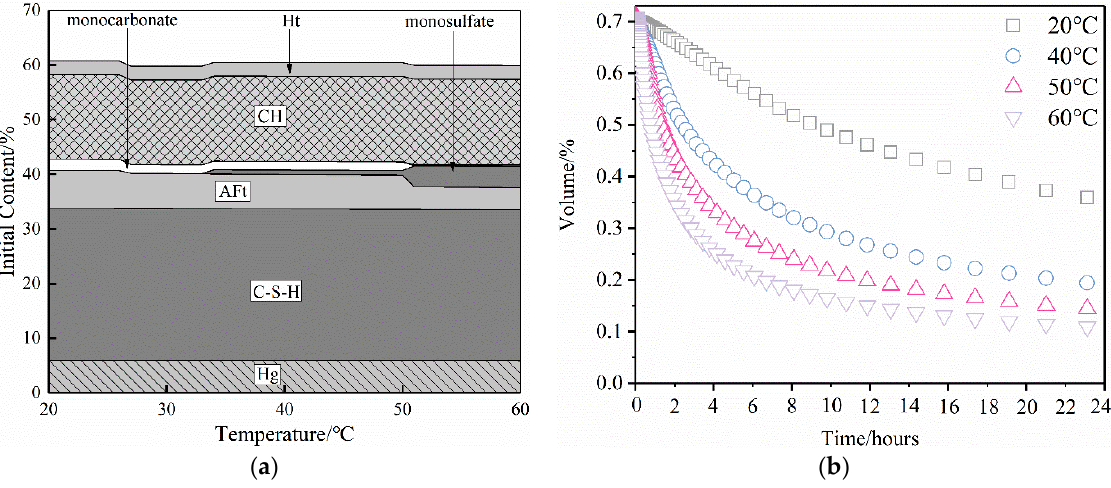
Figure 7. Relationship between hydration products and temperature: ( a ) change in hydration products with temperature; ( b ) hydration of C 3 A at different temperatures. C-S-H, Calcium Silicate Hydrate; CH, Calcium Hydroxide; AFt, Ettringite; Ht, Hydrotalcite; Hg, Hydrogarnet.